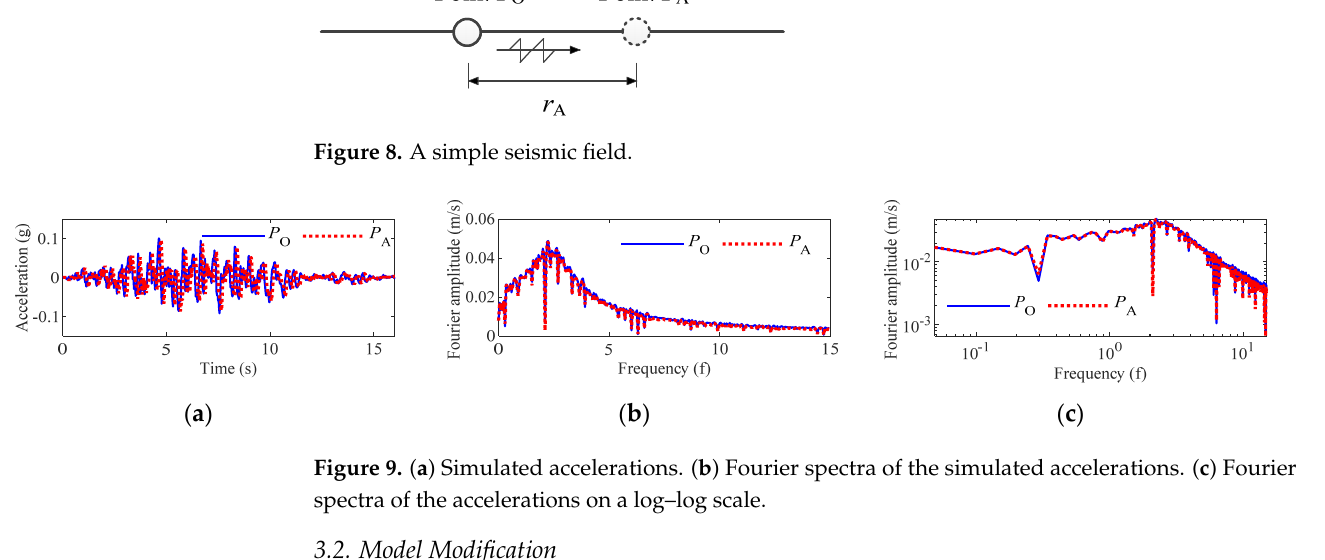
( c ) Figure 7. ( a ) Accelerations tested by SMART-1. ( b ) Fourier spectra of the accelerations. ( c ) Fourier spectra of the accelerations on a log-log scale.